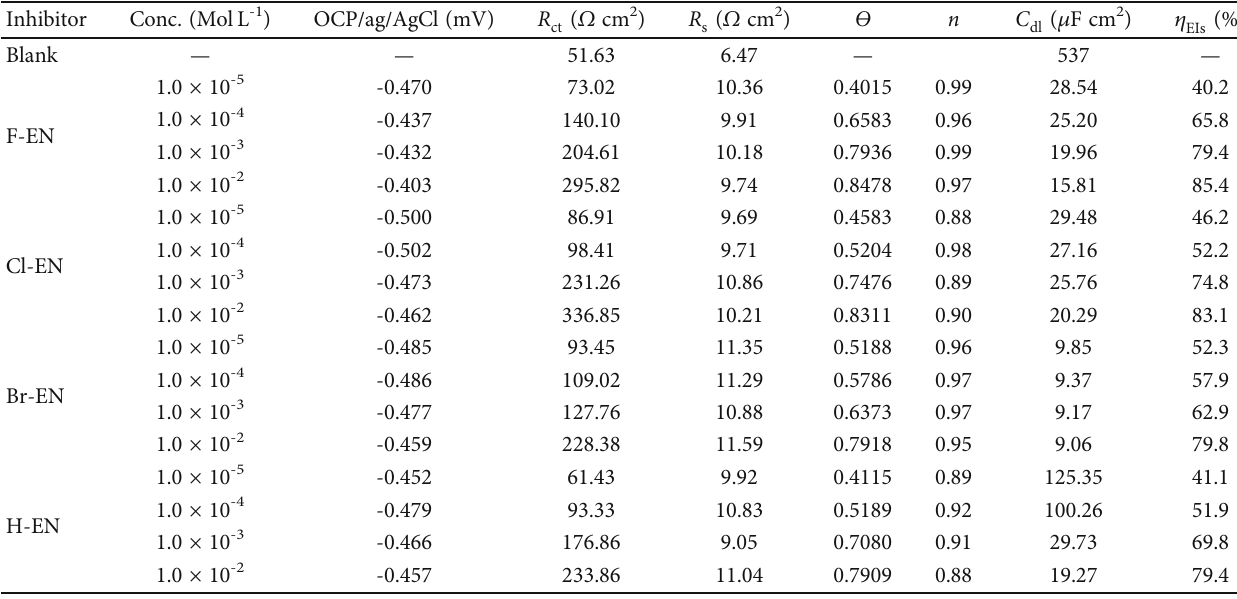
Table 2: Electrochemical parameters obtained through EIS tests of AISI 1020 carbon steel in 1.0molL -1 HCl medium at di ff erent concentration of enaminoesters.